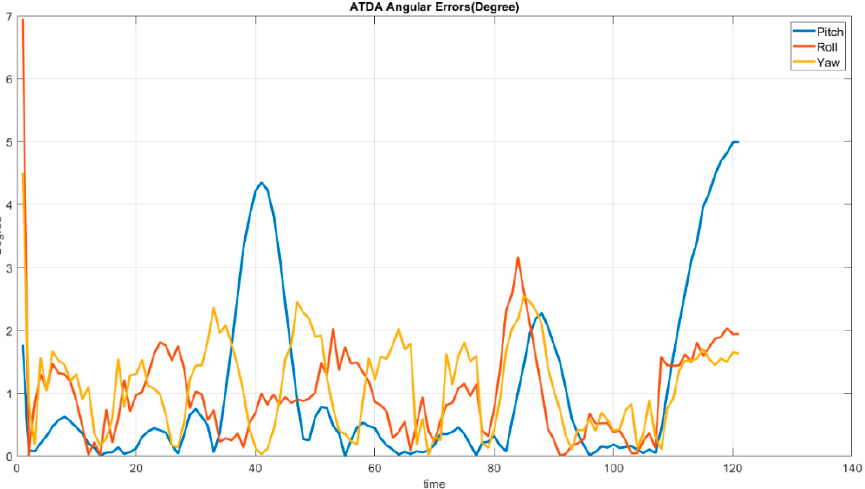
Figure 20. ATDA base Stewart platform angular estimation error along the X (blue), Y (red), and Z (yellow) axes.